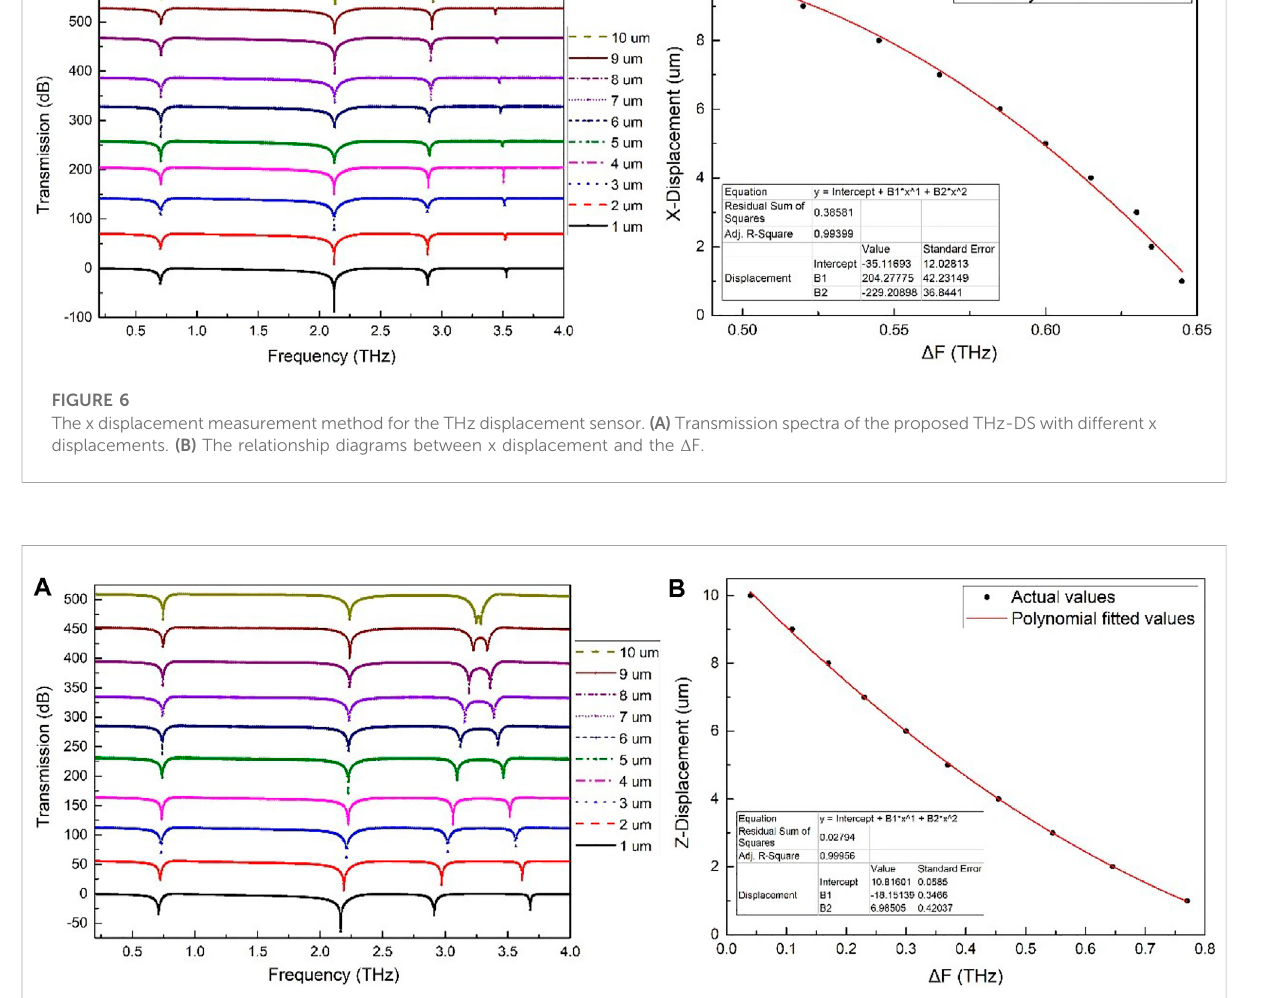
In this study, the THz-DS transmission spectrum with a displacement range of 1 – 7 µm in the y -direction and an interval step of 1 µm was also simulated and calculated. The distance of Δ F between the positions of the third and the fourth resonance transmission valleys gradually increases with the increase of y -direction displacement, as displayed in Figure 8. Formula (8) shows the relationship between the y -direction displacement and the transmission valley position difference Δ F , and three performance parameters of the sensor can be obtained: S is 145 GHz/ μ m, Q value is 144.25, and FOM is 7.7, as shown in Table 1.